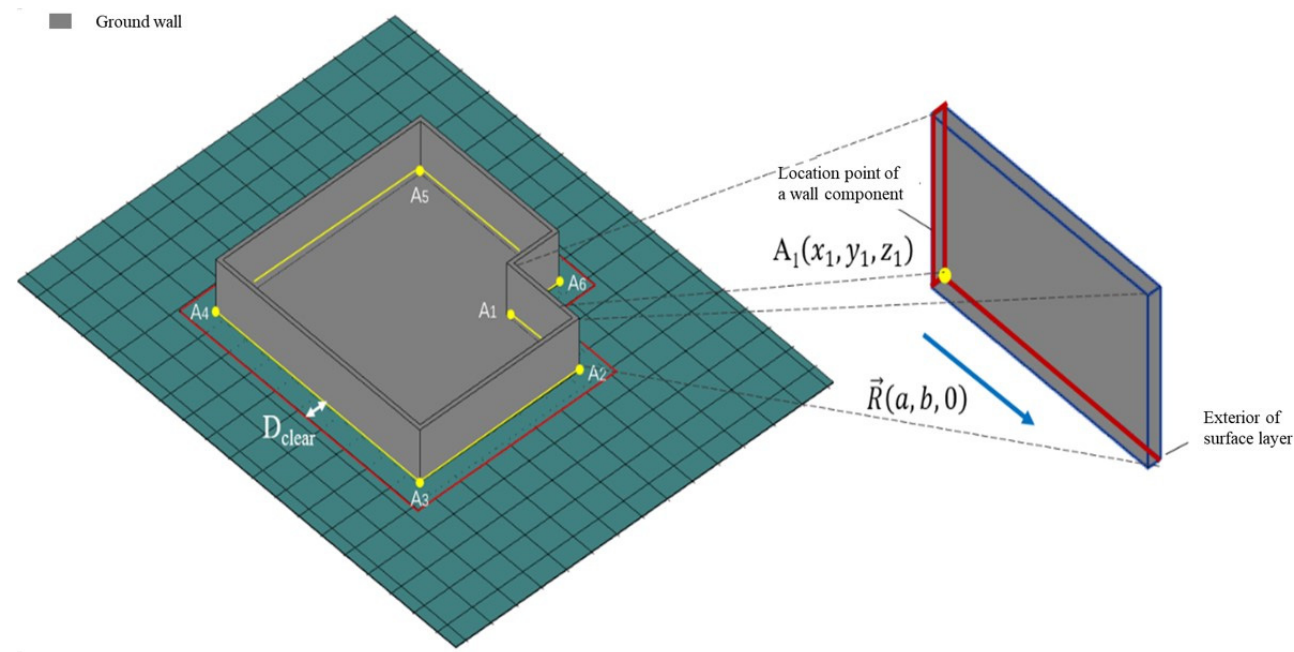
Figure 2. Building coverage area.